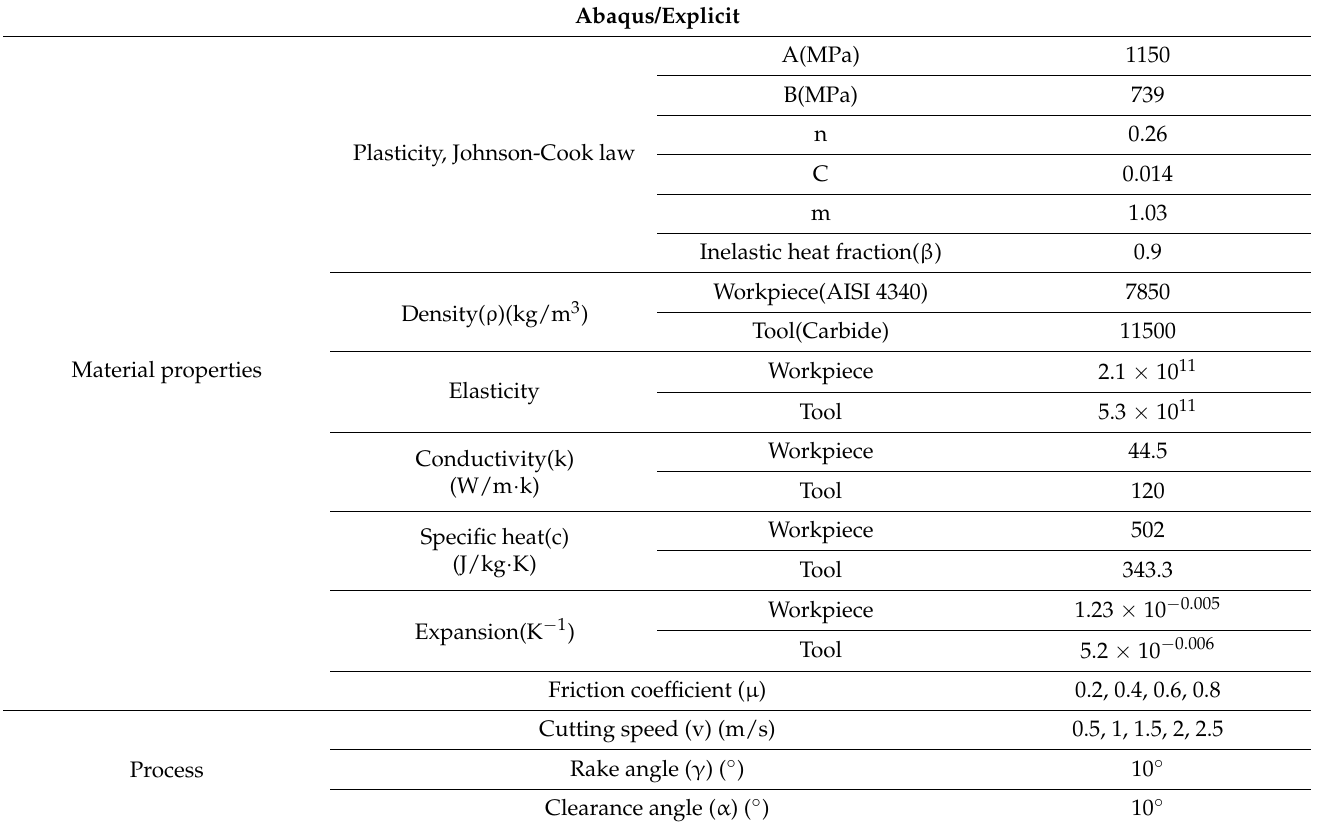
Table 1. Material properties and cutting conditions for the process simulations